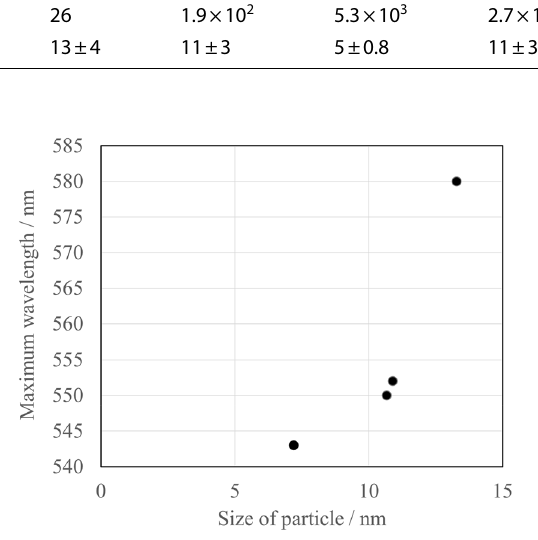
Table 2 Average particle size and number per unit area of AuNP in AuNP/TiO g) sample